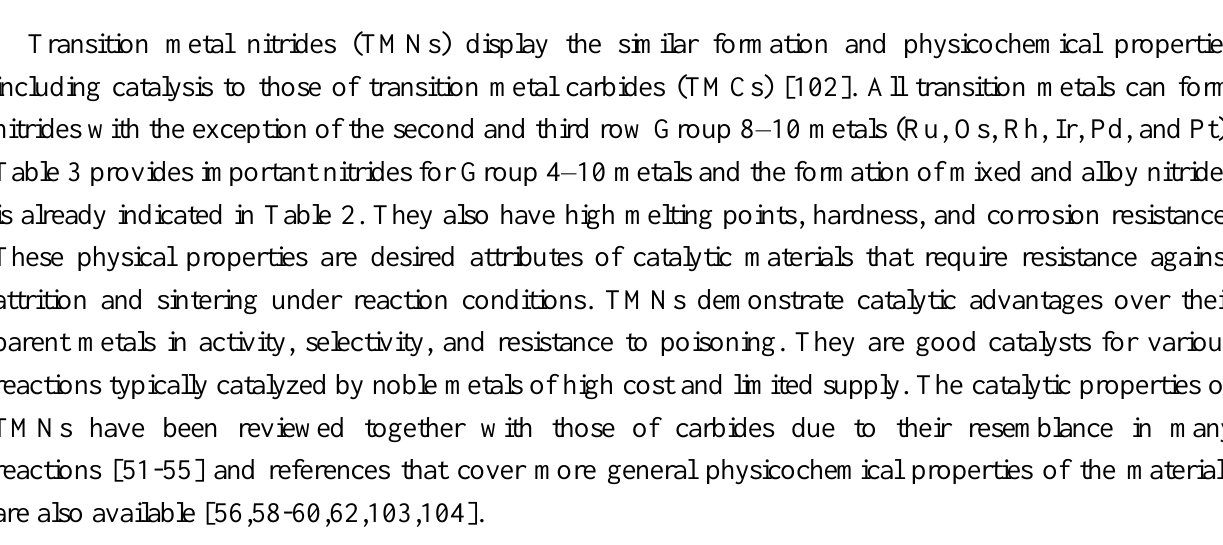
Table 3. Transition metal nitrides and their positions in the periodic